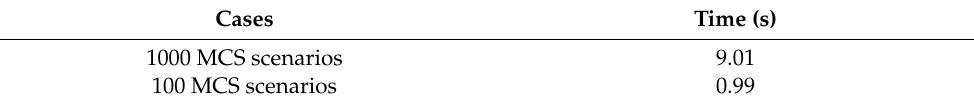
Table 5. Computational Performance of the Proposed Model for One Time Interval.